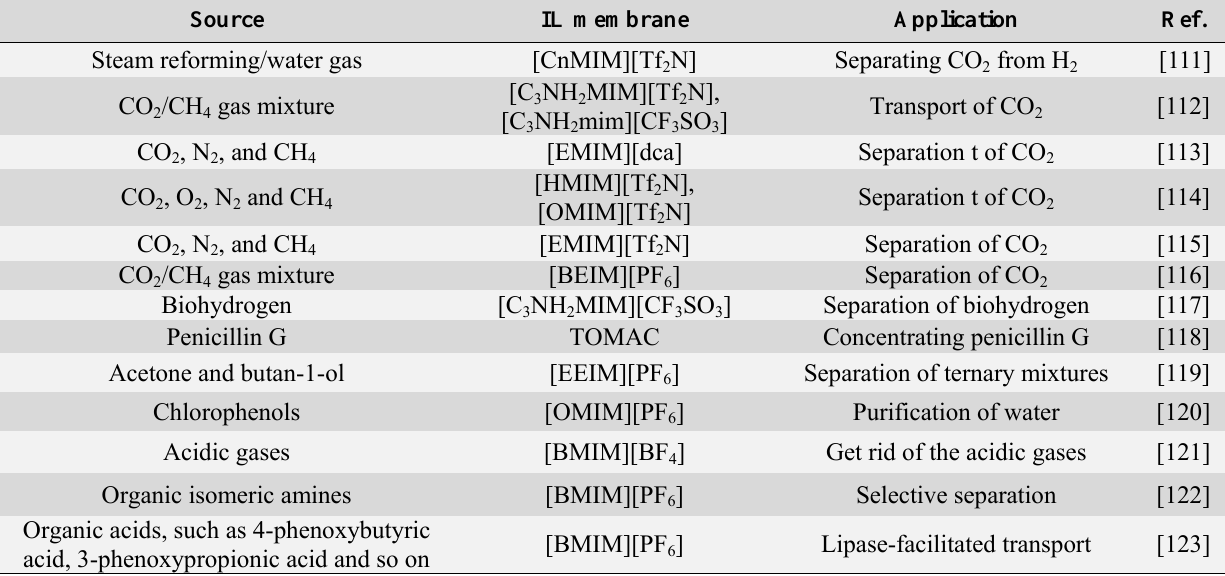
Table 6. Use of SILMs in gas and organic compounds